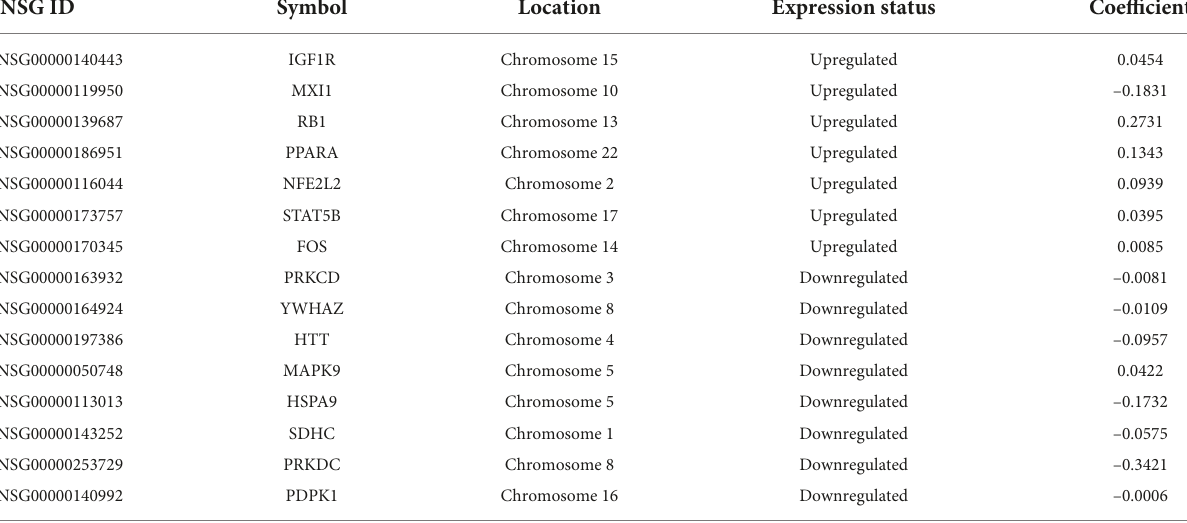
TABLE 2 The 15 genes associated with the risk model in Alzheimer’s disease